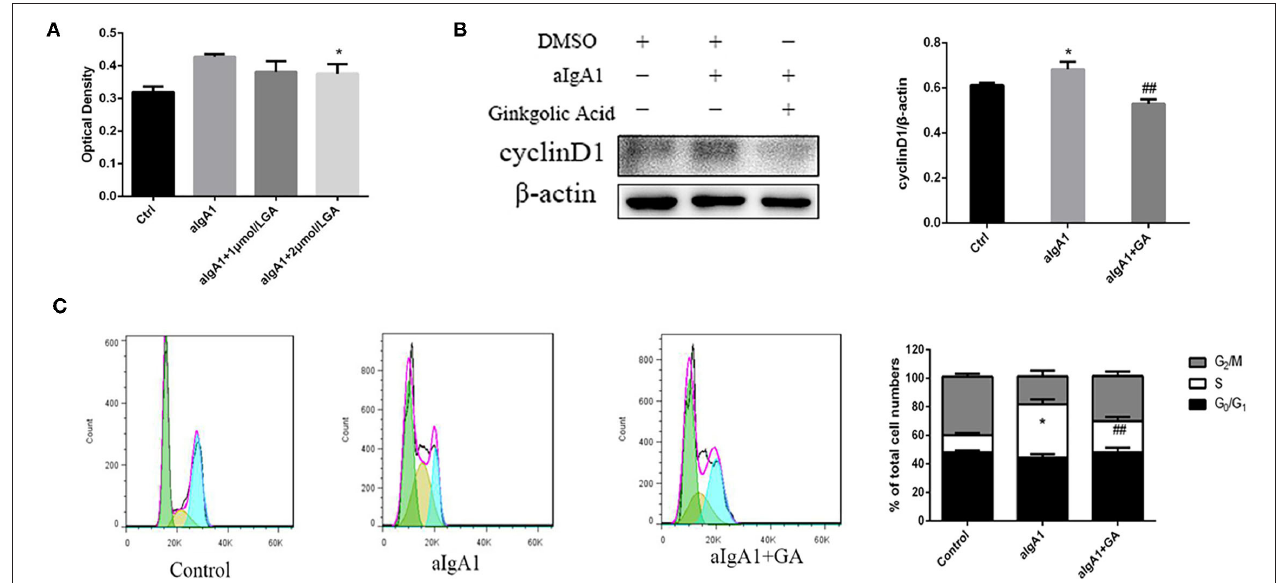
FIGURE 3 | Effects of SUMOylation inhibitors on human mesangial cells’ proliferation induced by aIgA1. (A) CCK8 analysis of mesangial cells proliferation among groups stimulated with aIgA1 and GA. (B) Western blot analysis for Cyclin D1. (C) Cell cycle of mesangial cells was analysised by Flow cytometry. Cells were treated with aIgA1 and Ginkgolic Acid. Data were presented as mean ± SD ( n = 10). * p < 0.05 vs. control, ## p < 0.01 vs. aIgA1